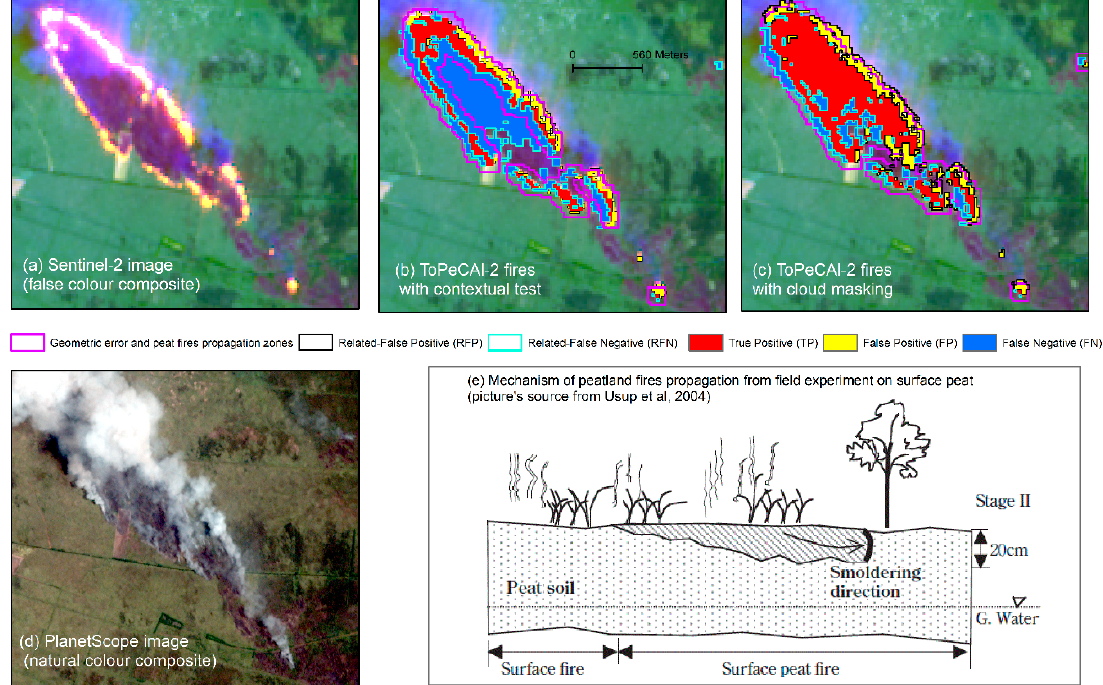
Figure 13. ( a ) Peatland fire areas ( ± 104 ha) presented in false colour composite for Sentinel-2 image on 28 September 2018 in Central Kalimantan. Light pink to yellow represented fire areas with bluish smoke emanating from fire areas; ( b ) ToPeCAl-2 fires with contextual test overlaid on RGB image of Sentinel-2 in the same area with Figure ( a ). The RFP and RFN pixels are adjacent to TP fires (red colour). In this data pairs of Sentinel-2 and Landsat-8, the RFP and RFN pixels were within geometric error (38 m) and propagation zones (12 m) which about 50 m from TP pixels (magenta square line); ( c ) As per Figure ( b ) but from ToPeCAl-2 with cloud mask; ( d ) PlanetScope image in natural colour composite showed smoke emanating from fires areas from in the same area and in three minutes after Sentinel-2 ′ s acquisition; ( e ) Surface peatland fires propagation in lateral (horizontal) direction according to [54] from field experiment in Central Kalimantan’s peatland after ignition and during surface burning in the first stage; the propagation were also in depth spread in the next stage.